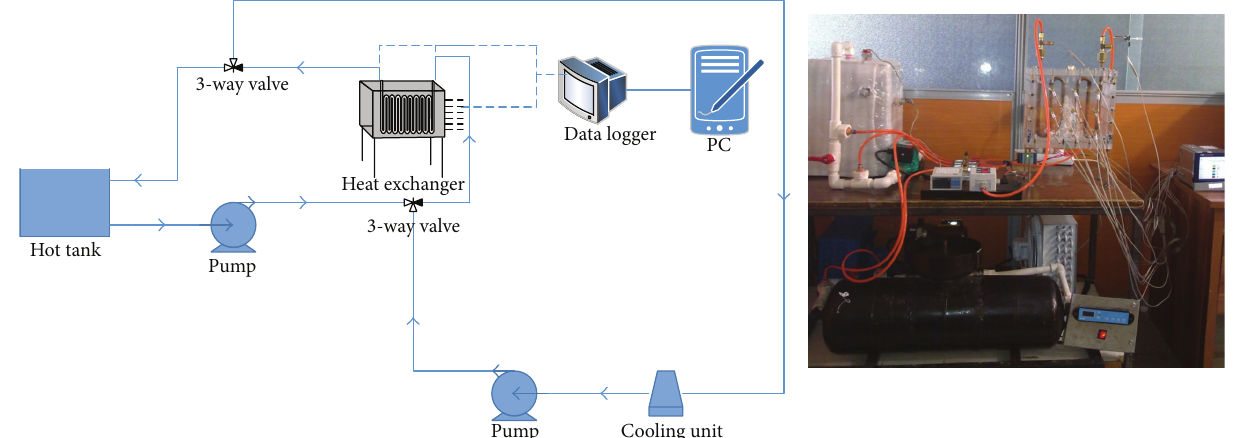
Figure 1: Schematic diagram and photograph of the experimental set-up.